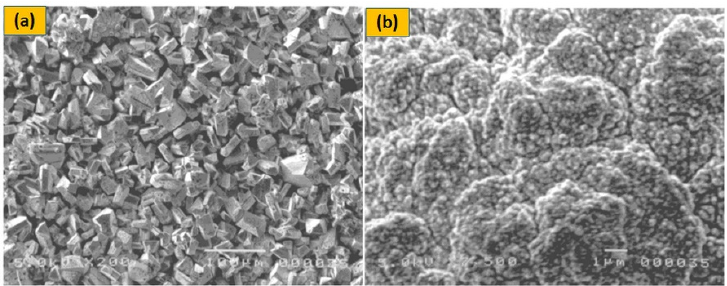
Figure 3. SEM images of CuI crystals deposited on the dyed TiO 2 porous film: ( a ) CuI without molten salt; ( b ) CuI/1-methyl-3-ethyl-imidazolium thiocyanate composite electrolyte, adapted from reference [42]. [Reproduced with kind permission].